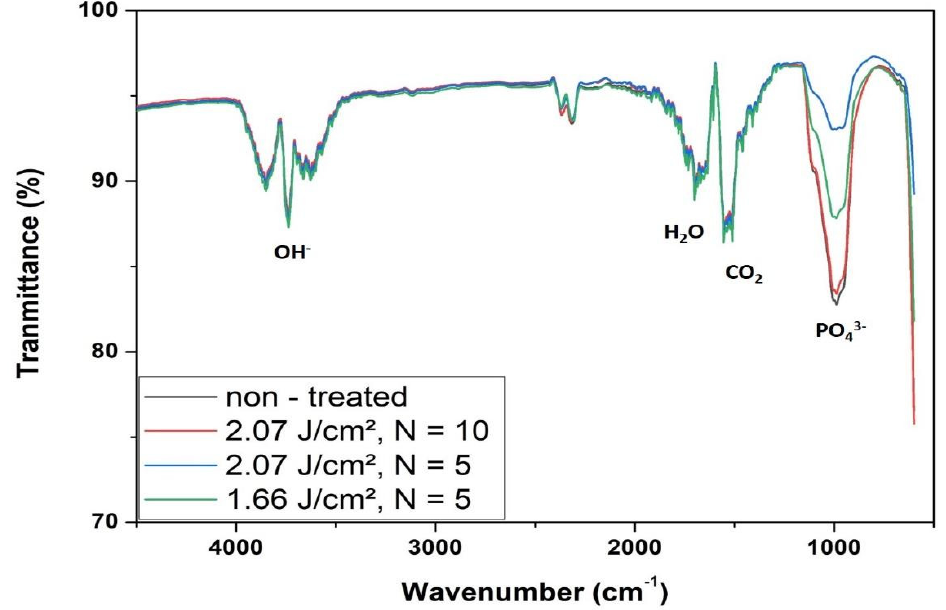
Figure 7. FTIR spectrum of β -TCP surfaces untreated/treated by laser irradiation at F = 1.66 and 2.07 J/cm 2 , N = 5 and 10.